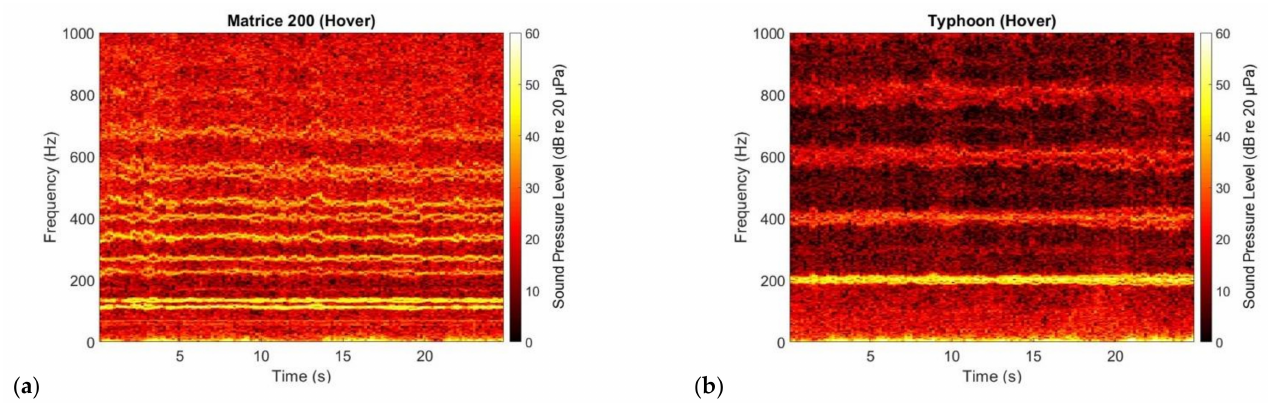
Figure 3. Spectrogram of the DJI M200 ( a ) and Yuneec Typhoon ( b ) UAVs hovering at ~1.2 m (~4 ft) altitude above the microphone